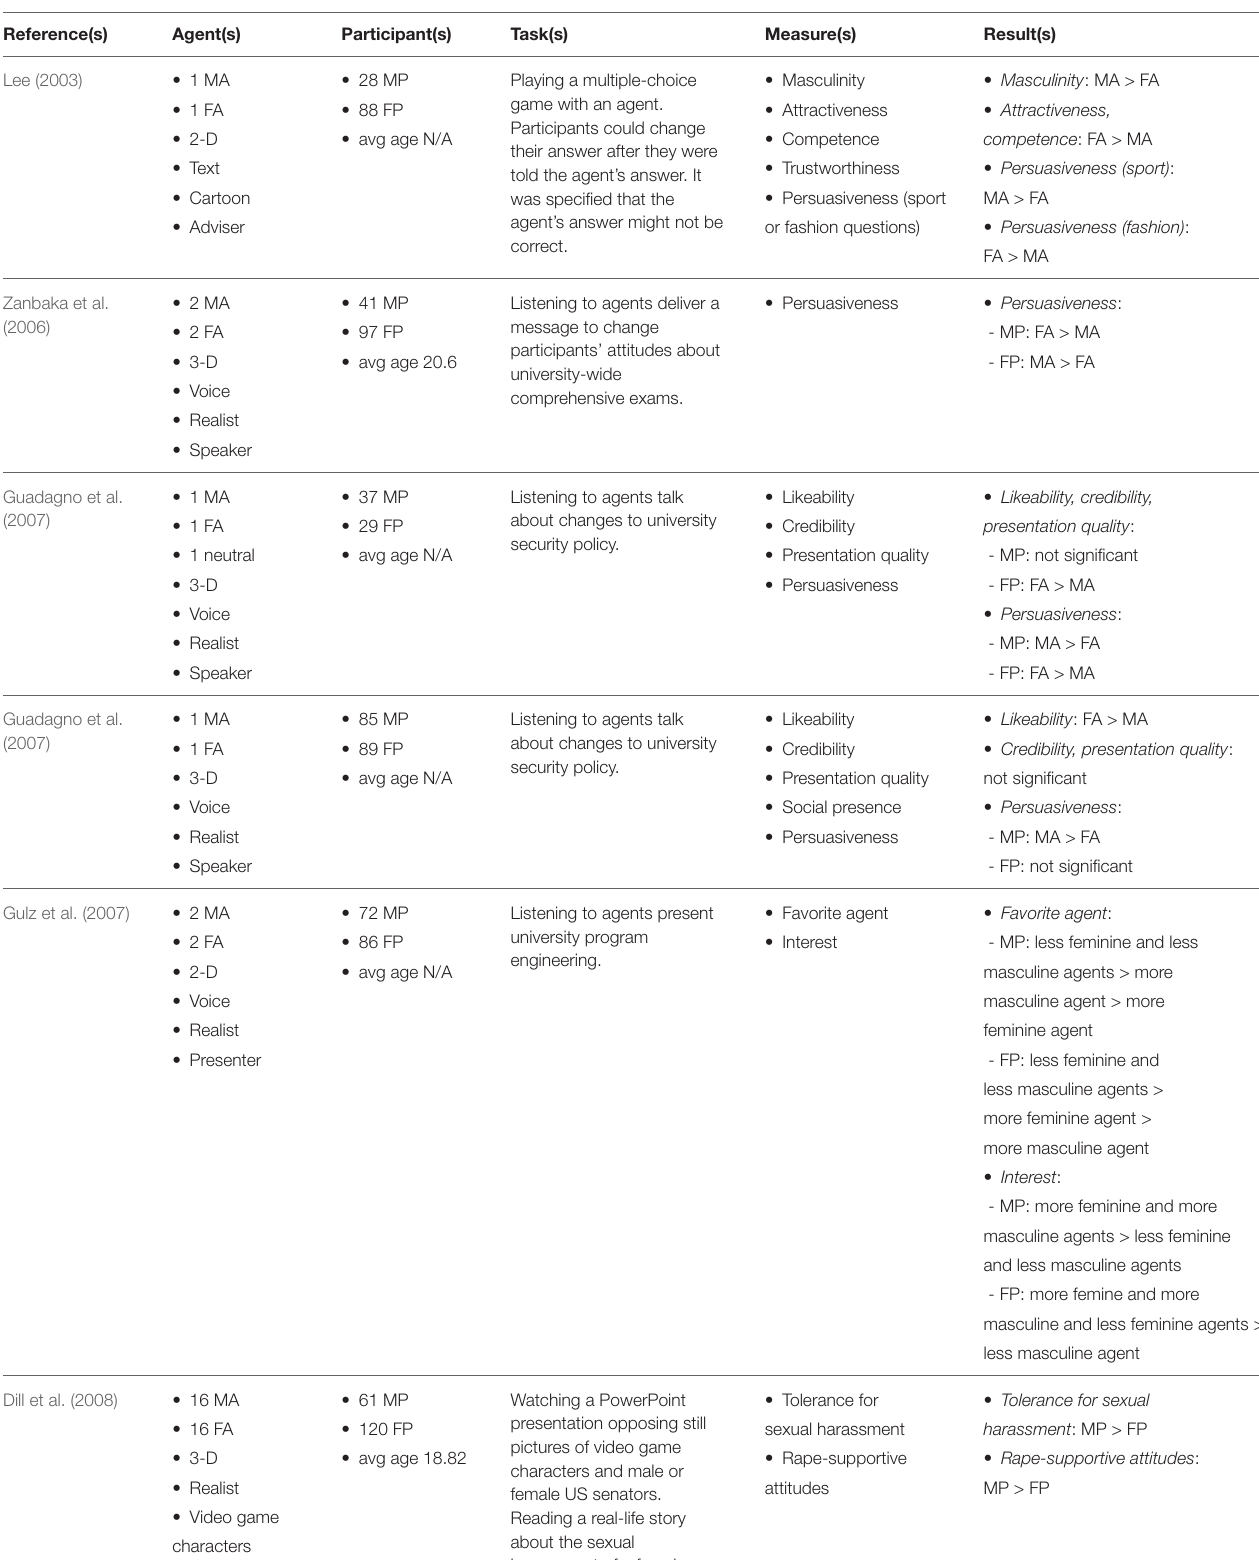
TABLE 1 | Summary of articles on perceptive studies of virtual agents depending on their gender, regardless of the application domain.